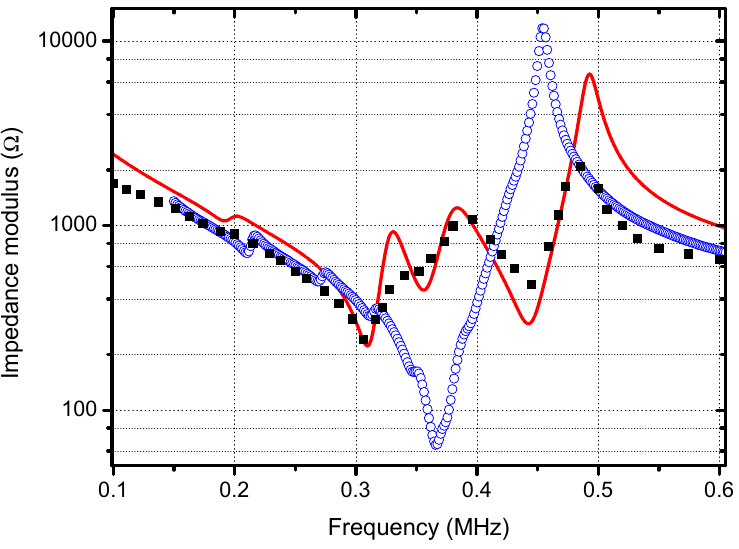
Figure 9. Electrical impedance (modulus) versus frequency of the final transducer measured in the terms of the piezocomposite disk. Black dots measurements, solid red line: calculations. Open circles: measured impedance of the piezocomposite